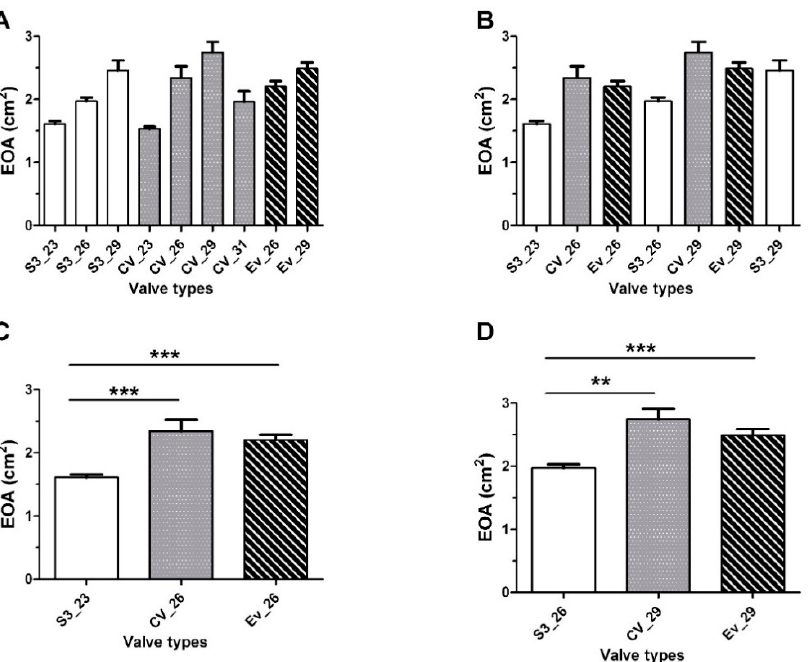
Figure 1. Effective orifice areas (EOAs; panels ( A , B )) in patients implanted with Sapien S3 ® 23 mm, 26 mm, or 29 mm valves (S3_23, S3_26, and S3_29, respectively), CoreValve ® 23 mm, 26 mm, 29 mm, or 31 mm valves (CV_23, CV_26, CV_29, and CV_31, respectively), or Evolut ® R 26 mm or 29 mm valves (EV_26 and EV_29, respectively). Panels ( C , D ) show the EOAs of the Sapien S3 ® , CoreValve ® , and Evolut ® R prostheses in patients with similar aortic annulus sizes. ** p < 0.01 and *** p < 0.0001 for Sapien S3 ® versus CoreValve ® or Sapien S3 ® versus Evolut ® R. Abbreviations: LVEF, left ventricular ejection fraction; MG, transvalvular aortic mean gradient; SVi, stroke volume indexed to the body surface area; AVA, aortic valve area; AR, aortic regurgitation; MR, mitral regurgitation; LVOT, left ventricular outflow tract; Area-derived diam, aortic annulus area-derived diameter; Ann area, annulus area; Ann perim, annulus perimeter; AU, Agatston units At discharge, the transaortic MG was found to differ significantly among different prostheses as follows: 11.74 ± 3.45 mmHg for S3 23 mm ( n = 74); 9.59 ± 3.63 mmHg for S3 26 mm ( n = 67); 8.95 ± 2.94 mmHg for S3 29 mm ( n = 20); 14.5 ± 6.36 mmHg for CV 23 mm ( n = 2); 6.70 ± 3.97 mmHg for CV 26 mm ( n = 15); 6.40 ± 3.22 mmHg for CV 29 mm ( n = 24); 7.48 ± 3.57 mmHg for EVR 29 mm ( n = 27). Despite differences in EOAs, MG at follow-up remained stable across different sizes of the same valve, the only exception being S3 23 mm—whose MG was higher than that of S3 26 mm ( p = 0.013) and also slightly increased between the first and the sixth month after implantation ( p =